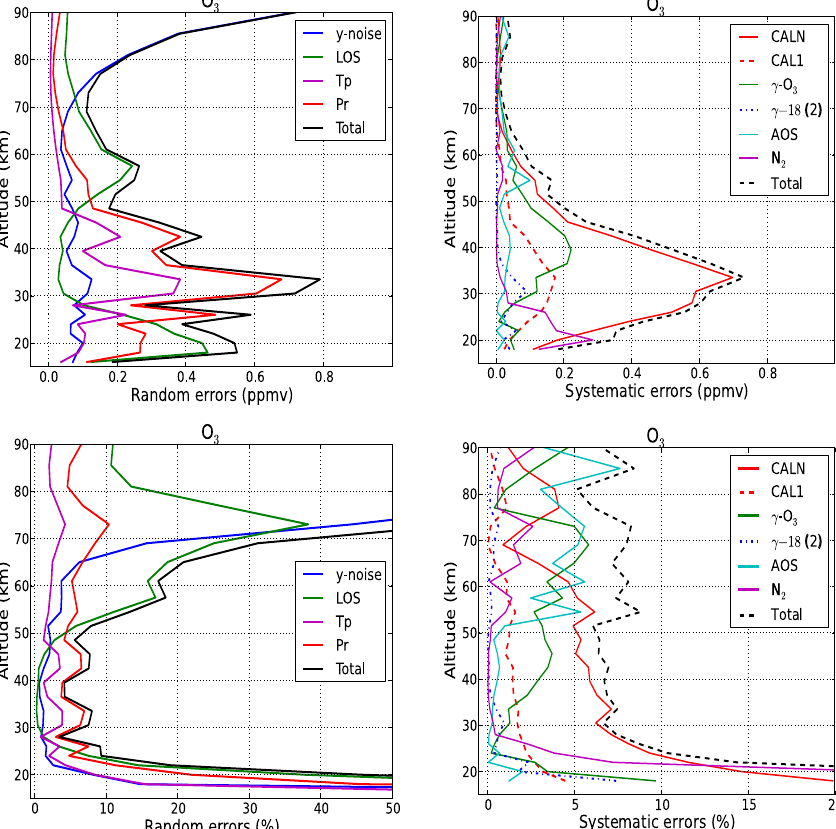
Fig. 9. Random (left panels) and systematic (right panels) errors on the O 3 profile retrieved from window A/B-w1. The absolute and relative errors are shown in the upper and lower panels, respectively. Random errors are from the measurement noise (blue line), temperature profile (magenta line), pressure profile (red line), line-of-sight angle (green) and the total random error (black line). The meaning of the labels of the systematic errors and the assumed errors on the parameters are given in Table 5. The black line is the total error calculated as the root-sum-square of all sources of error.